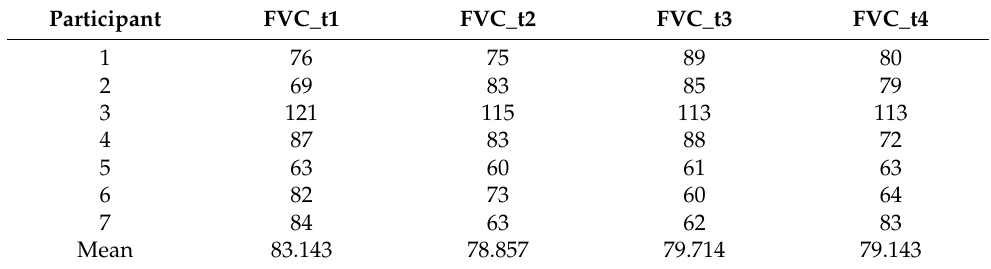
Table 3. FVC (%) individual and mean measurements at four assessment time points.